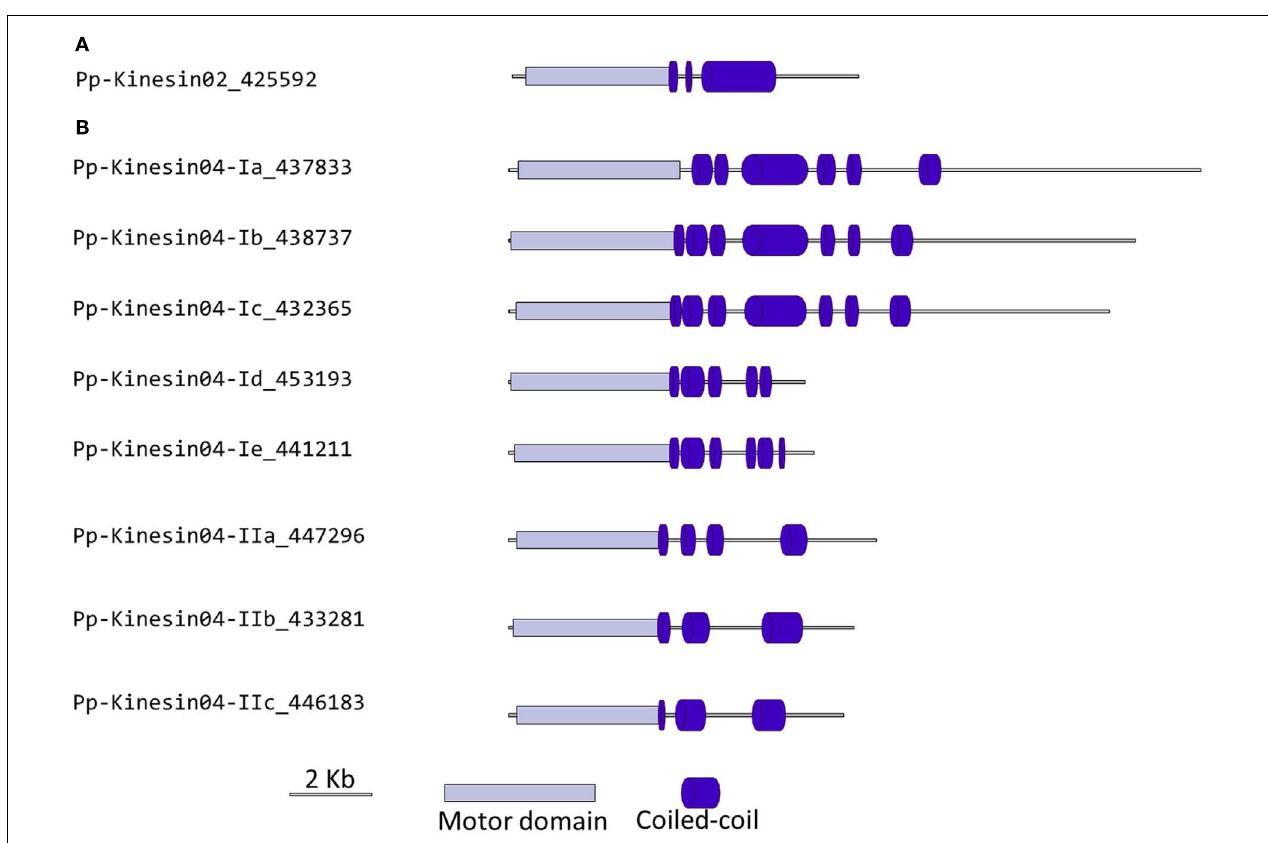
FIGURE 3 | Gene models of kinesin 2s and 4s. Schematic diagrams showing the structure and domain architecture of (A) kinesin 2s and (B) kinesin 4s. Domains are indicated at the bottom of the diagrams.